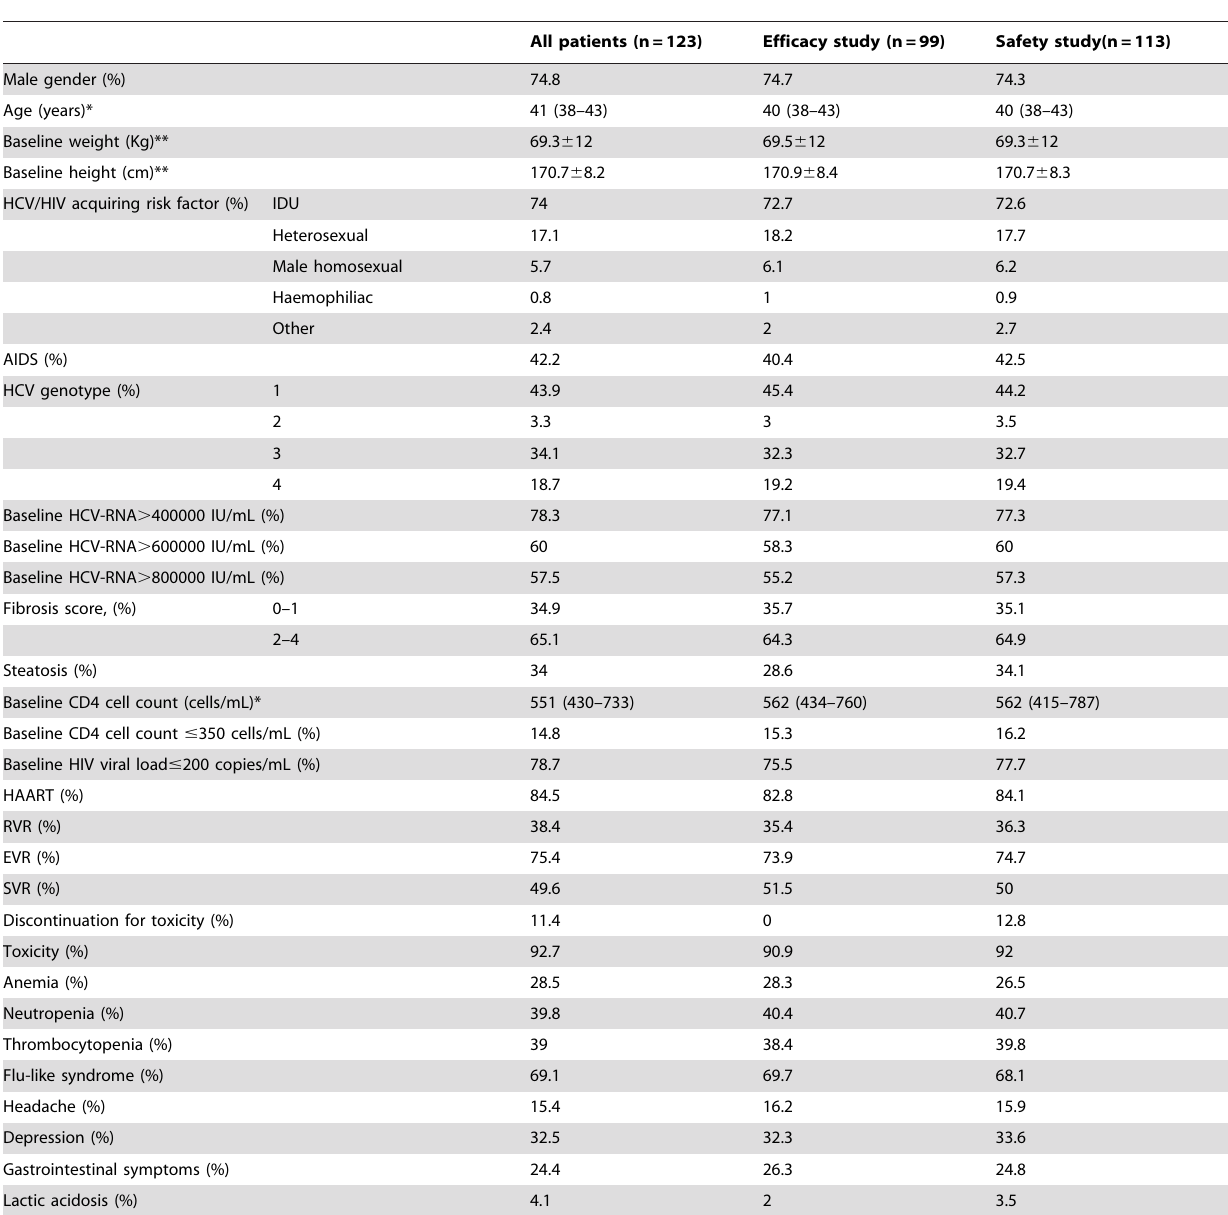
Table 2. Main demographic and clinical characteristics of the groups studied.